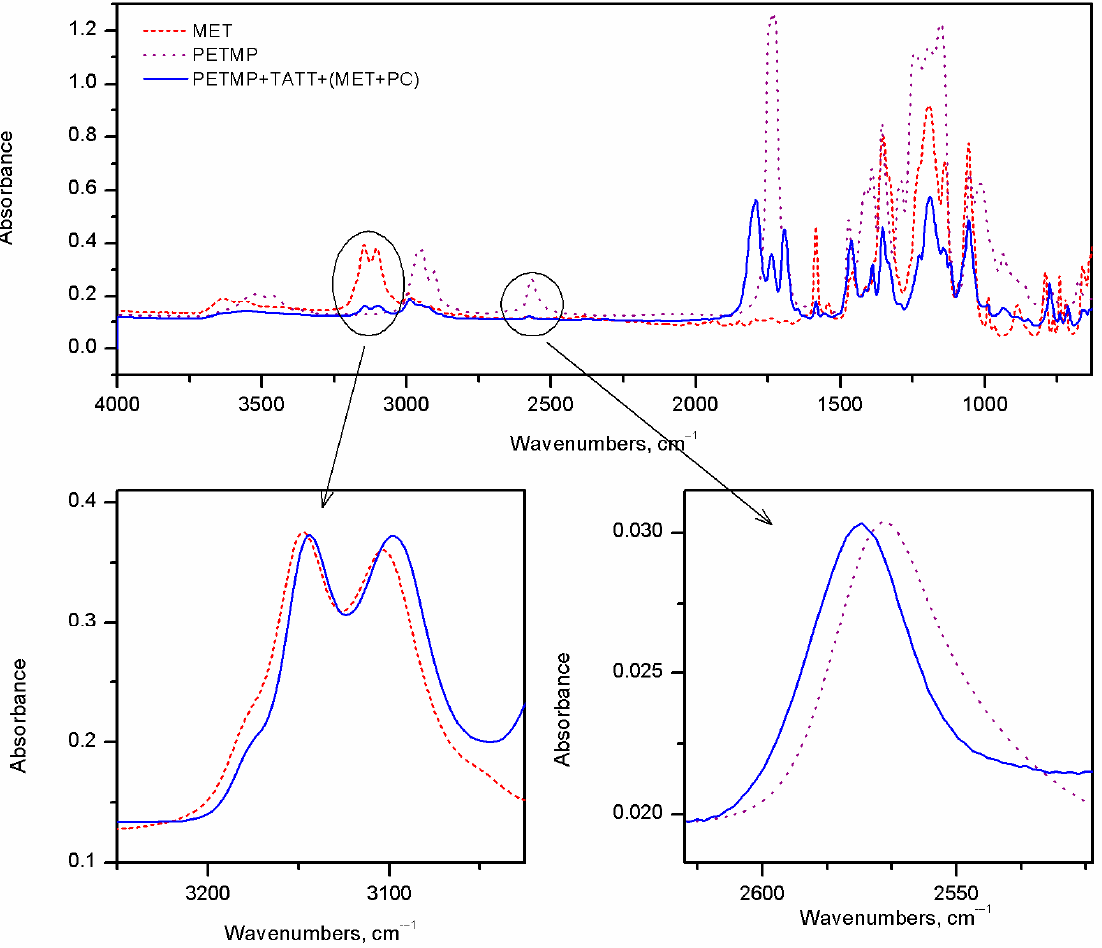
Figure 3. FTIR spectra of pristine PETMP (thiol monomer), METNTf 2 (triazolium ionic liquid), and a composition of PETMP+TATT+MET+PC. Additionally, shifts in the investigated absorption bands C3-H and C5-H of the triazole ring and SH group of thiol are shown (the absorbance has been normalized to show shifts in the studied bands).